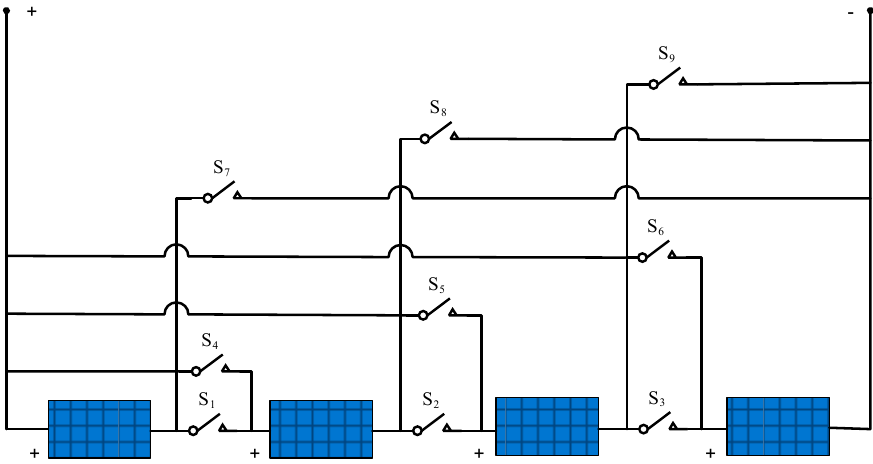
Figure 3. Topology structures obtained with the algorithm proposed in [24], reproduced from the proceedings of the TENCON 2009, IEEE: 2009. The number of switches necessary in case 3 is equal